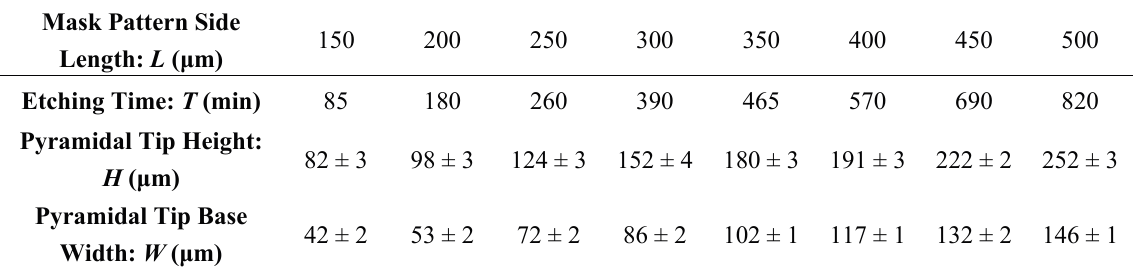
Table 1. Pyramidal microtip etching time and the measured KOH etching results for various side lengths ( L ) of the square pattern of the etching